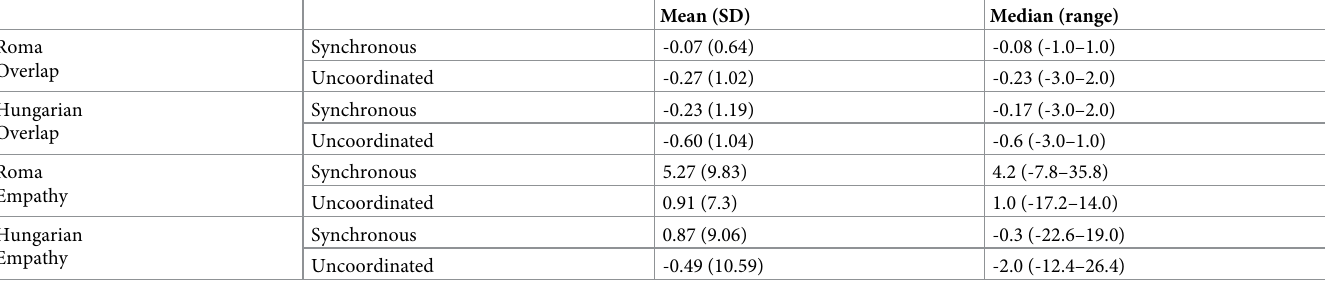
Table 7. Shows the descriptive statistics for Empathy and Overlap change scores towards each group type in Study 2.